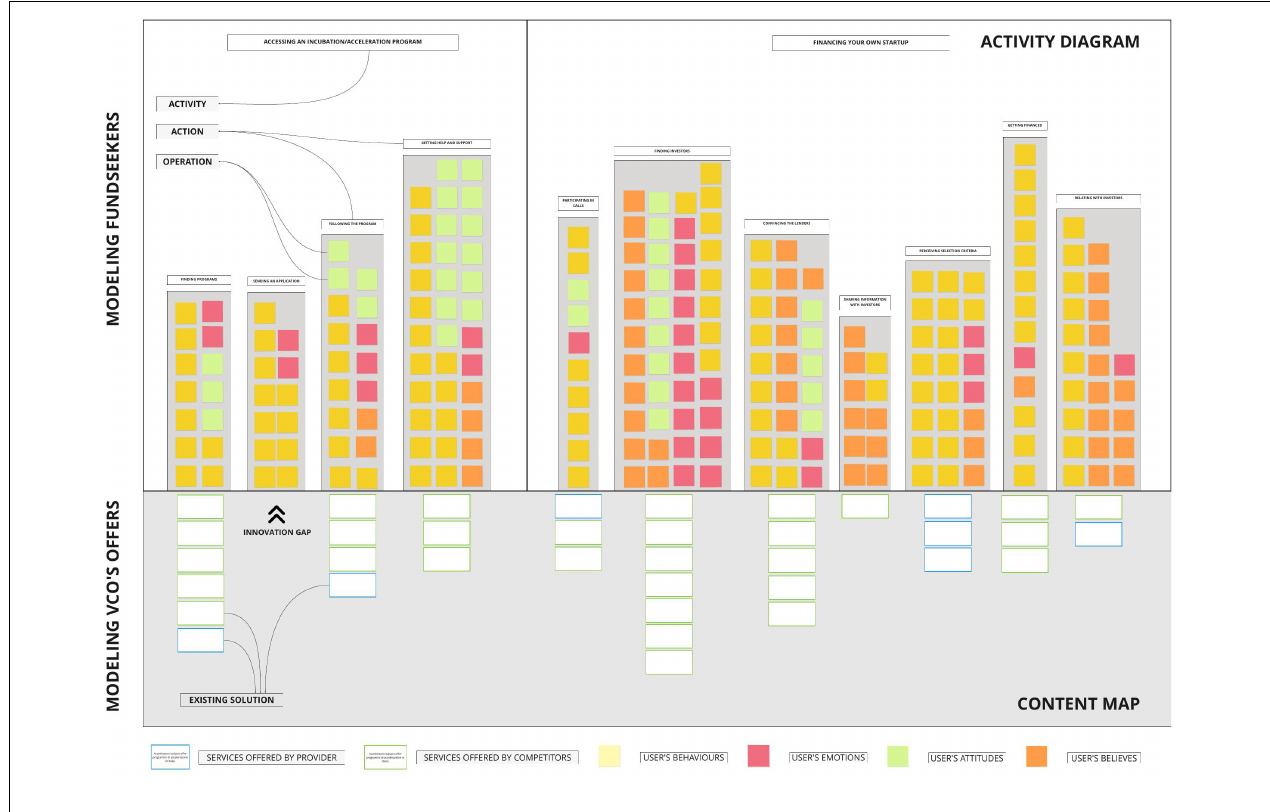
FIGURE 2 | Structure of the activity